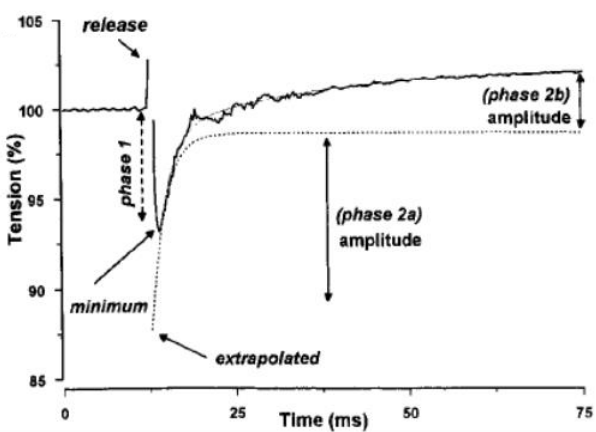
Figure 16. The tension transient to a pressure release in an intact fibre. A double exponential curve can be fitted to the tension recovery. The calculated rates for Phases 2a and 2b were ~500 and 50/s, (adapted from Vawda, Geeves, and Ranatunga, 1999, [20]).